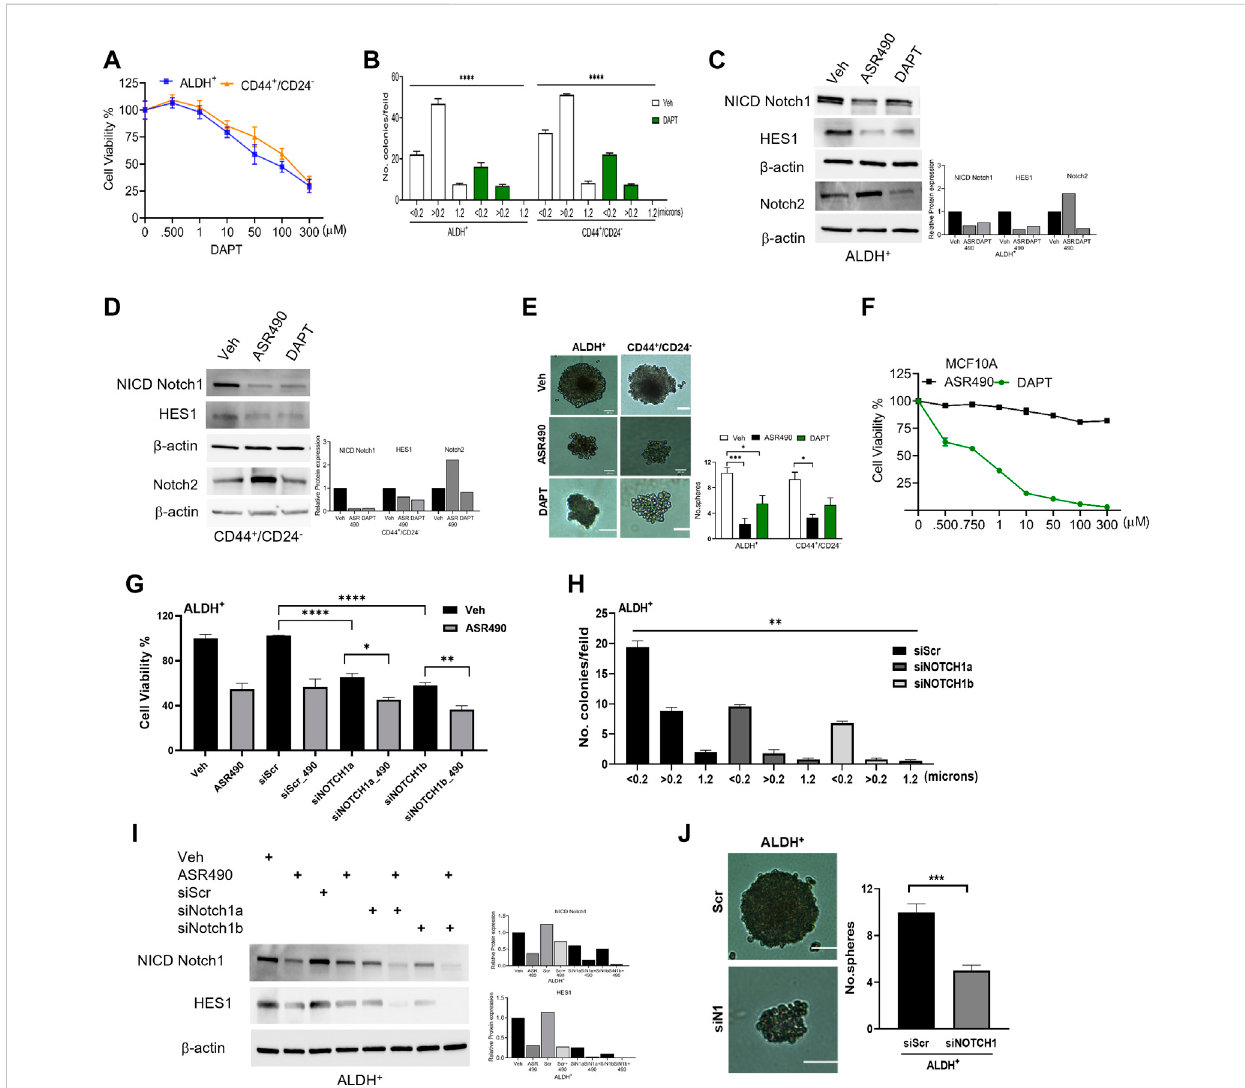
FIGURE 3 Pharmacological and genetic approaches to inhibit Notch1 signaling in BCSCs. (A) MTT cell viability assay performed on ALDH + and CD44 + /CD24 − cells following treatment with variousconcentrations ofDAPT (0, 0.500, 1,10,100, and 300 µM)for 24 h( n =6). (B) Colony-forming assay ofvehicle and DAPT-treated ALDH + and CD44 + /CD24 − cells ( n = 6; **** p < 0.0001). (C, D) Western blots for Notch1-NICD (the active form of Notch1), HES1 and Hey1 and Notch2 of vehicle, ASR490 and DAPT-treated ALDH + (C) and CD44 + /CD24 − (D) cells. (E) Mammosphere assay performed for vehicle, ASR490, and DAPT-treated ALDH + and CD44 + /CD24 − cells ( n = 4, * p < 0.02 and *** p < 0.007). p values are based on one-way ANOVA with a post hoc LSD test. (F) MTT cell viability assay performed on MCF10A cells following treatment with various concentrations (0, 0.500, 0.750, 1, 10, 50, 100, and 300 µM) of ASR490 and DAPT for 24 h ( n = 6). (G) Cell viability and (H) colony forming assays for vehicle and ASR490 treated non-transfected, SCR- siRNA, and Notch1-siRNA transfected ALDH + cells for 24 h ( n = 6; * p < 0.01, ** p < 0.008, and **** p < 0.0001). p values are based on one-way ANOVA witha posthoc LSDtest. (I) WesternblotsforNotch-NICDandHES-1expressionwereperformedonvehicleorASR490treatedSCR-siRNA,andNotch1- siRNA transfected ALDH + cells. (J) Mammospheres assay performed for vehicle and ASR490 treated SCR-siRNA, and Notch1-siRNA transfected ALDH + cells ( n = 6; *** p < 0.001). p values are based on one-way ANOVA with a post hoc LSD